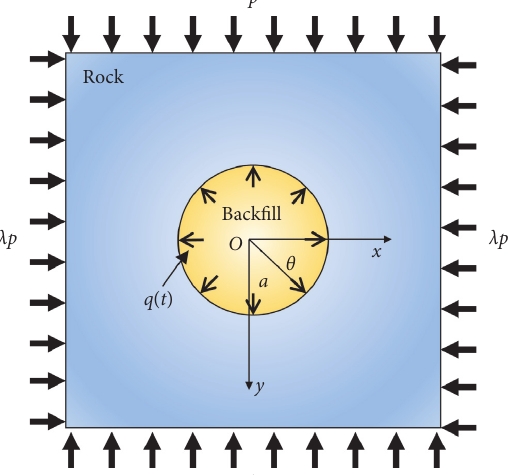
Figure 3: Schematic of the contact between weak fill support and nearby rock material deformation.